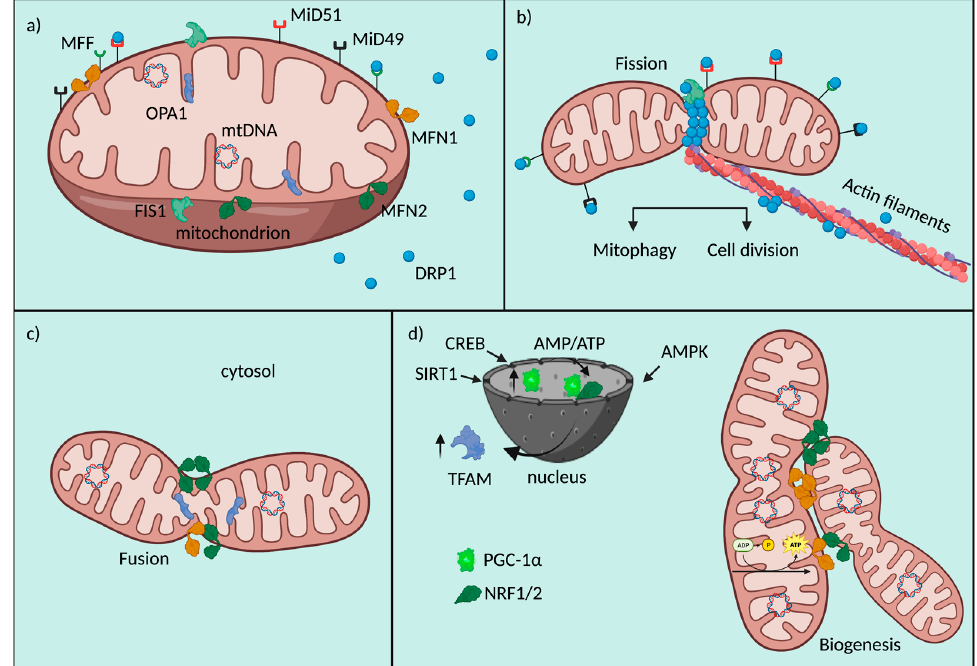
Figure 1. Fusion/Fission machinery. Schematic representation of mitochondrial fusion and fission machinery and their crosstalk with biogenesis. ( a ) Mitochondrial players involved in fusion, fission and biogenesis. ( b ) Mitochondrial fission is orchestrated by a series of molecular events involving OMM receptors (MFF, MiD49, MiD51, FIS1), which help the recruitment of DRP1 to the organelle. DRP1 results to be the main protein effector of mitochondrial fragmentation. ( c ) Mitochondrial fusion is allowed by the tethering properties of MFNs and the function of OPA1 at the IMM. ( d ) Mitochondrial biogenesis is at the crosstalk of a nuclear/mitochondrial gene reprogramming involving the upregulation of PGC-1 α , NRF1/2, TFAM, their nuclear interactions and fusion proteins.